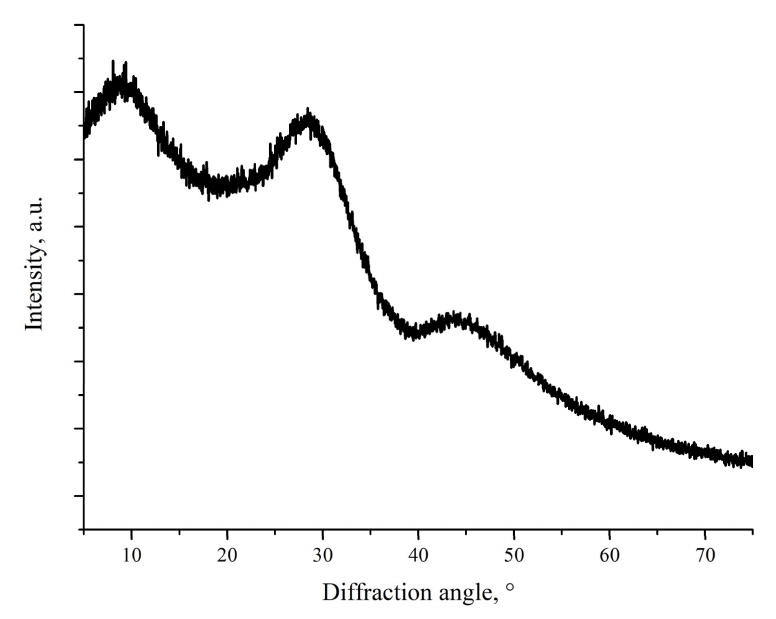
Figure 2. XRD pattern of as-quenched CaO-SiO 2 -B 2 O 3